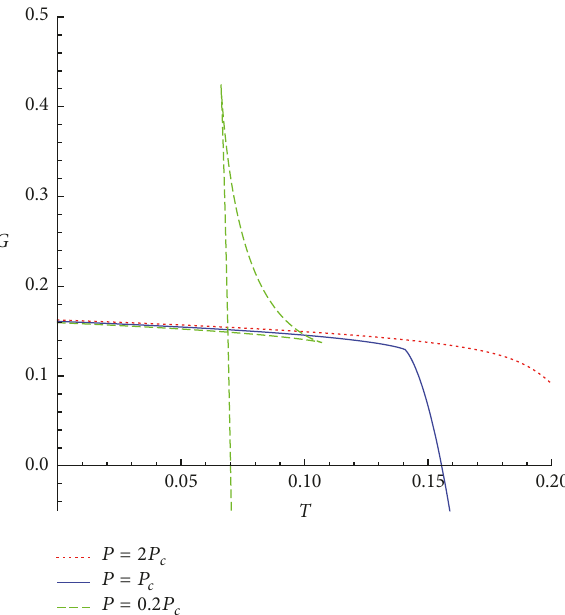
Figure3: 𝐺 - 𝑇 diagramofaSBHina 𝑓(𝑅) gravitycoupledwithYMF for different values of 𝑃 ( 𝑃 < 𝑃 𝑐 , 𝑃 = 𝑃 𝑐 , and 𝑃 > 𝑃 𝑐 ) with 𝑄 = 0.1 and 𝜂 = 1